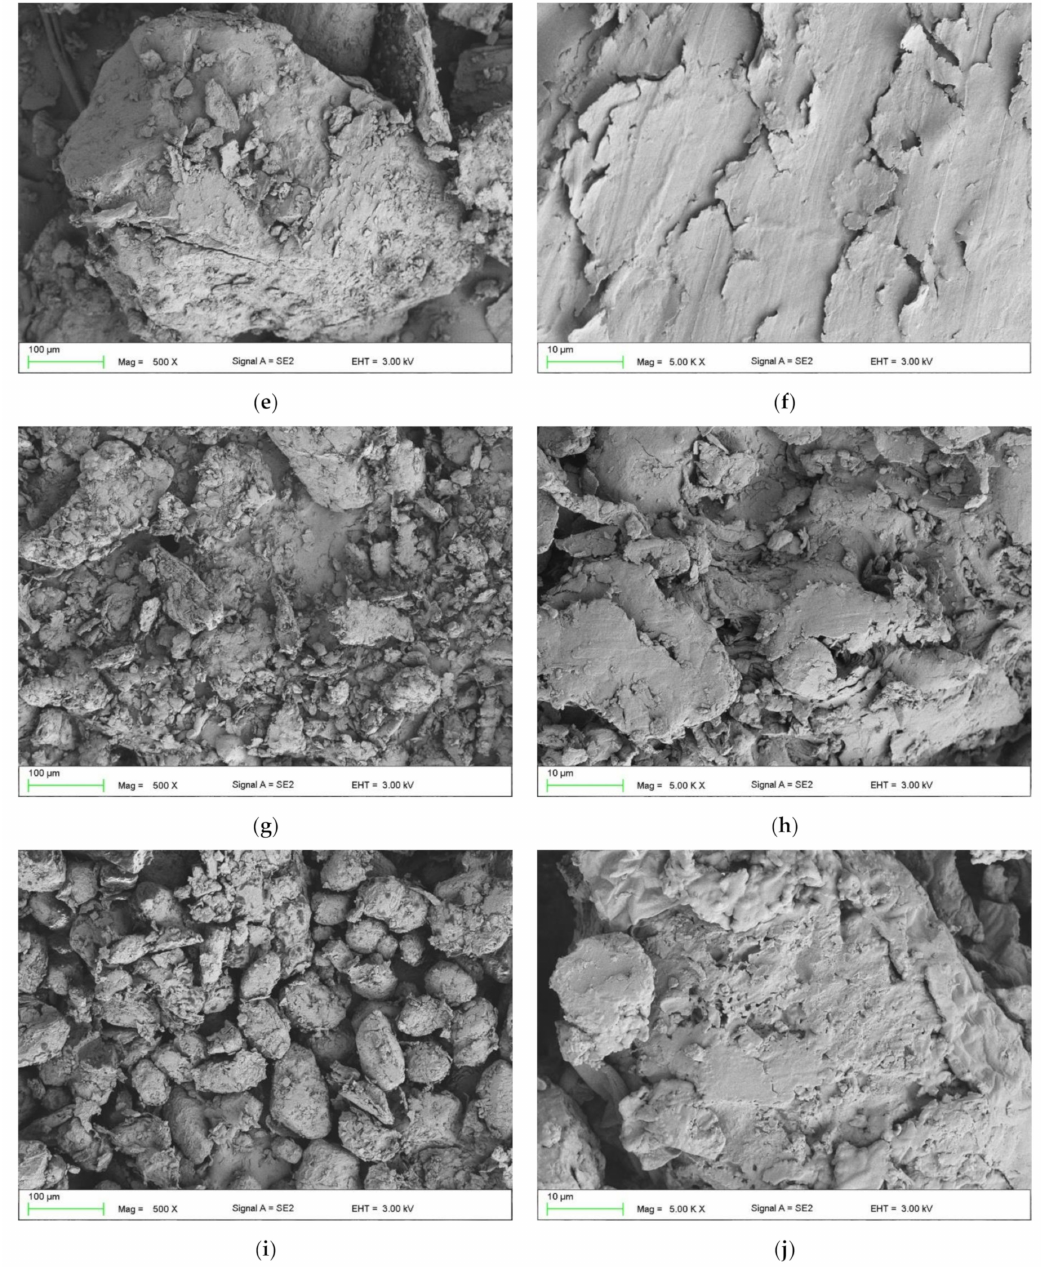
Figure 3. SEM images of ground coffee waste (GCW) ( a , b ), walnut shell (WS) ( c , d ), brewer’s spent grains (BSG) ( e , f ), pistachio shell (PS) ( g , h ), and chestnut (CH) ( i , j